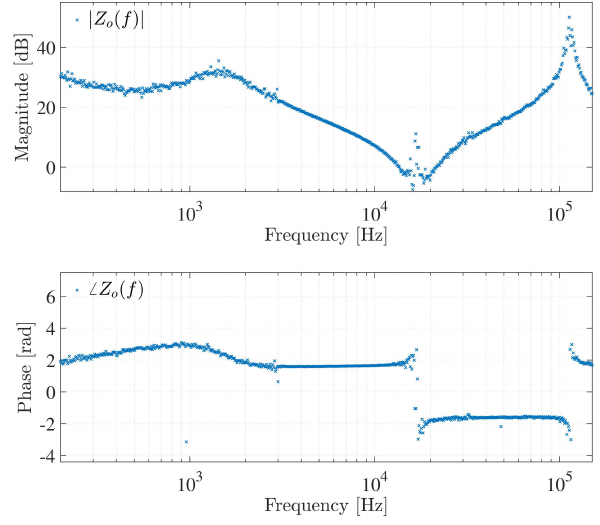
Figure 20. Magnitude and phase response of Z o ( f ) of the practical inverter under investigation using PRBS perturbation.